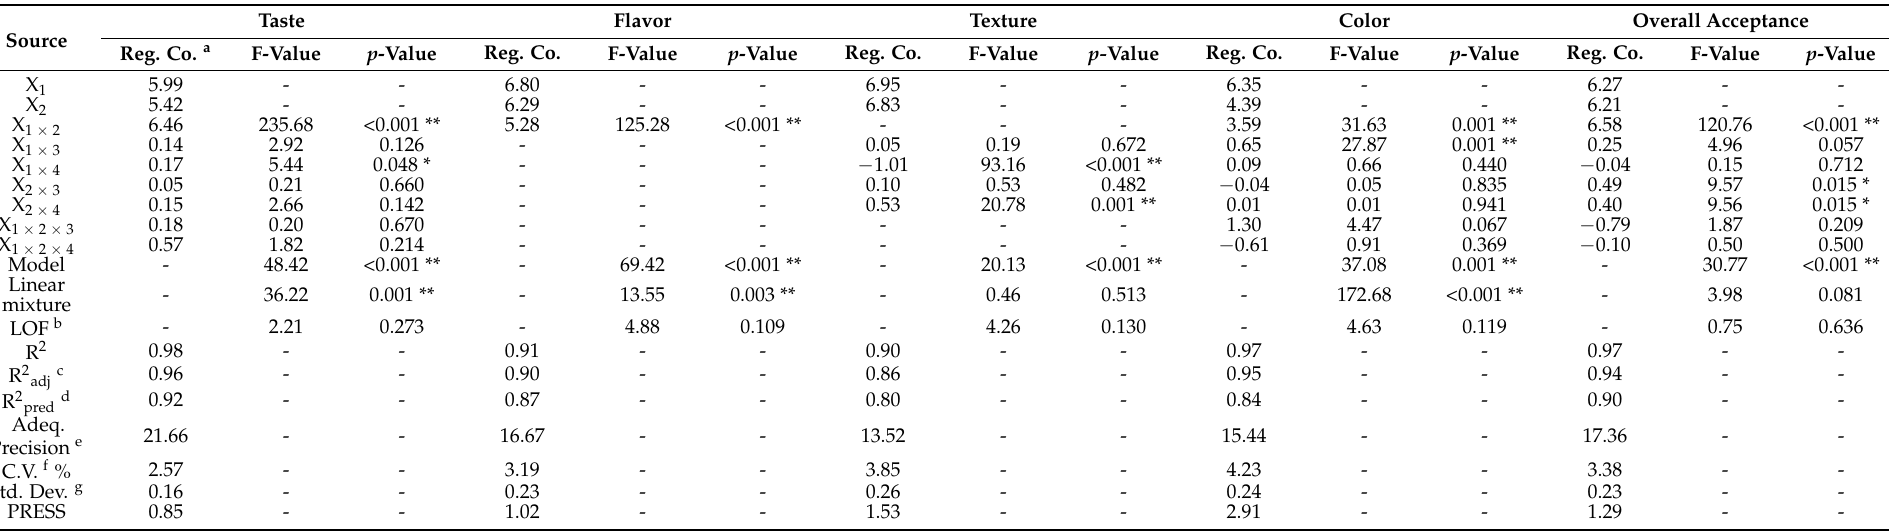
Table 3. Regression coefficients for the response variables and analysis of variance of the regression